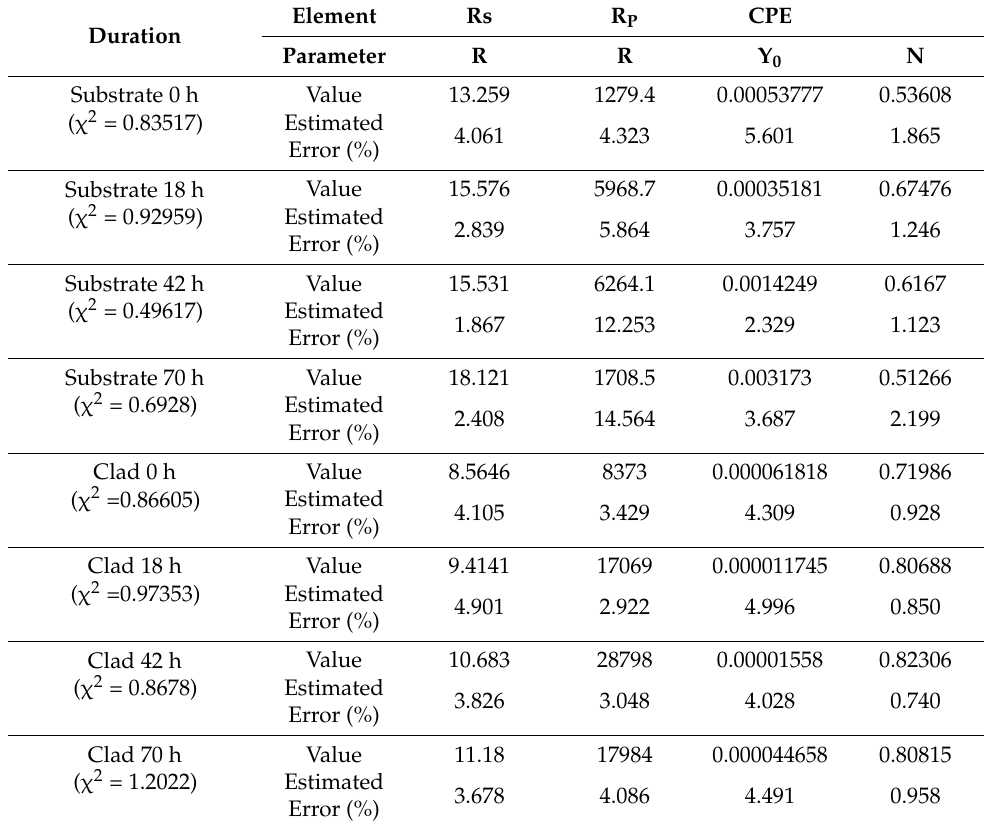
Table 5. The elemental compositions of both substrate and clad samples at different time